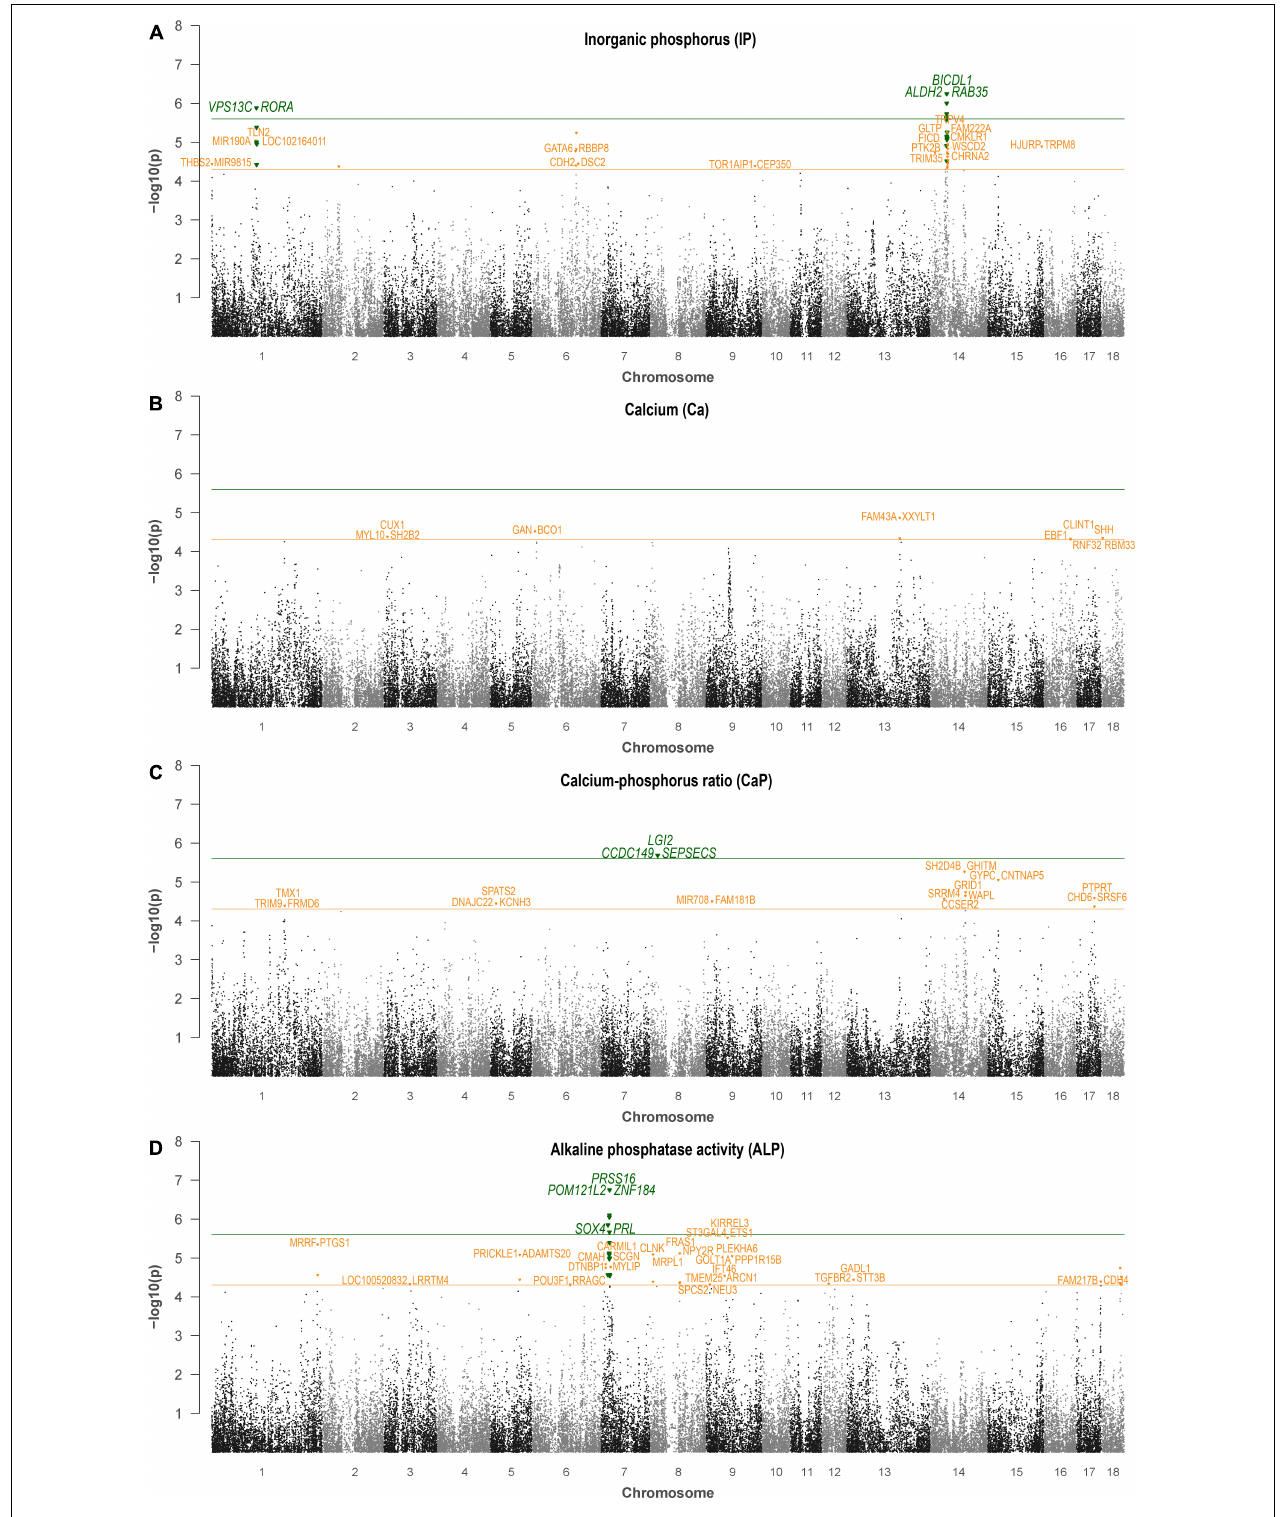
FIGURE 1 | Single-locus association analysis of hematological levels of IP (A) , calcium (B) , calcium/phosphorus ratio (C) , and ALP (D) . Orange and green lines indicate suggestive significance and genome-wide significance, respectively. Genes located closest to the lead SNP of a 2-Mb genomic windows are indicated.